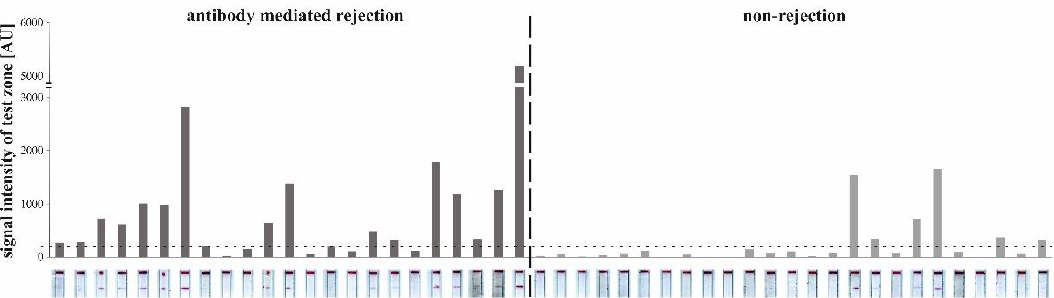
Figure 7. In total, 48 lateral flow assay strips tested with patient urine samples showing the test and control zone with the corresponding columns reflecting the signal intensity of the test line. Horizontal dashed line at 200 AU indicates the threshold between positive and negative test zone. N = 1.